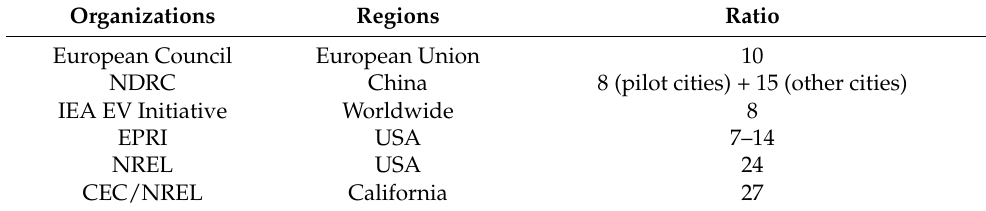
Table 11. EV to charge point ratio proposed by several organizations [36].